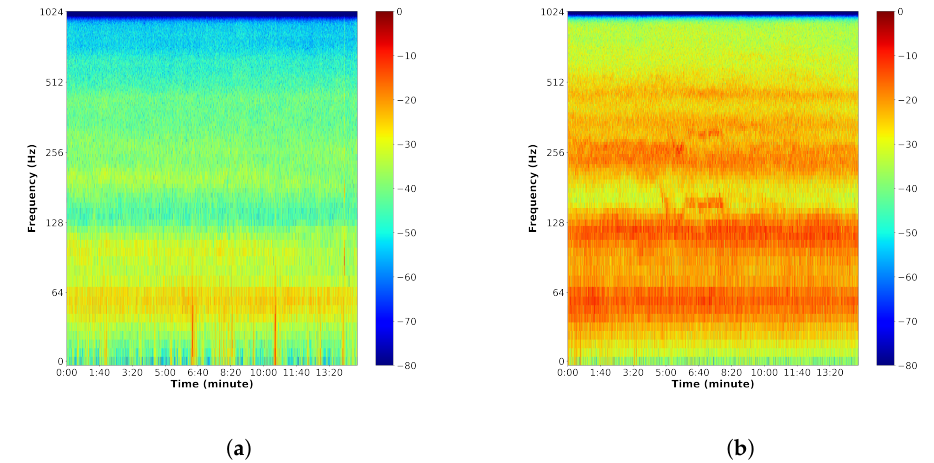
Figure 13. Spectrogram comparisons ( a ) without and ( b ) with heavy rainfalls.